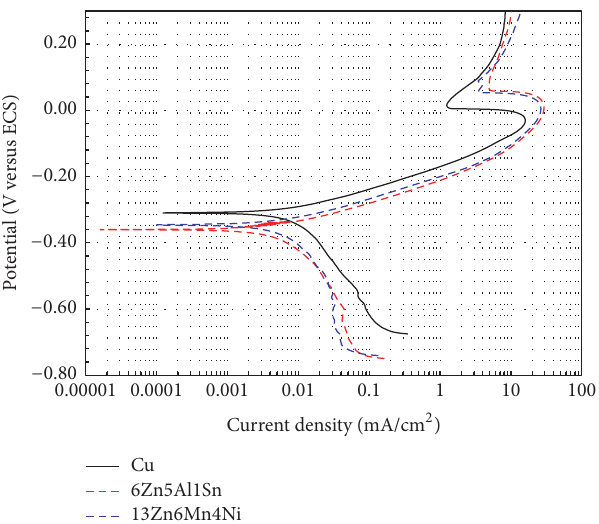
Figure 3: Polarization curves for the Cu-based quaternary alloys in artificial sweat at 37 ∘ C ( dE/dt = 1.0mV/s).